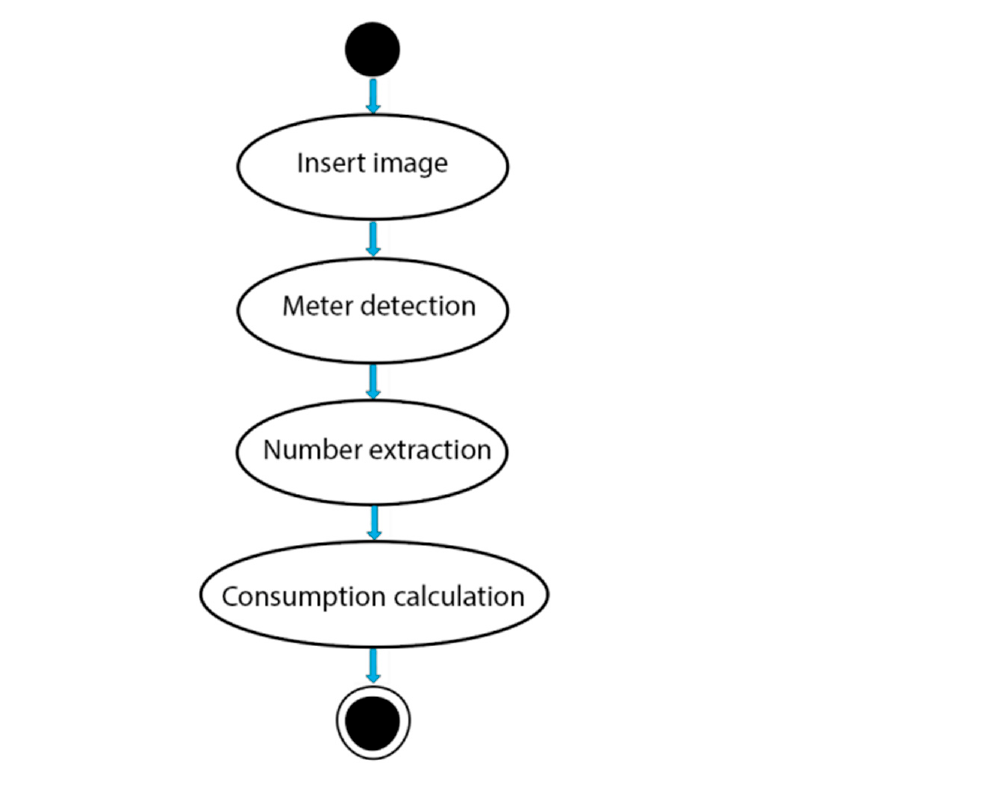
Figure 5. Flow chart of the Program.